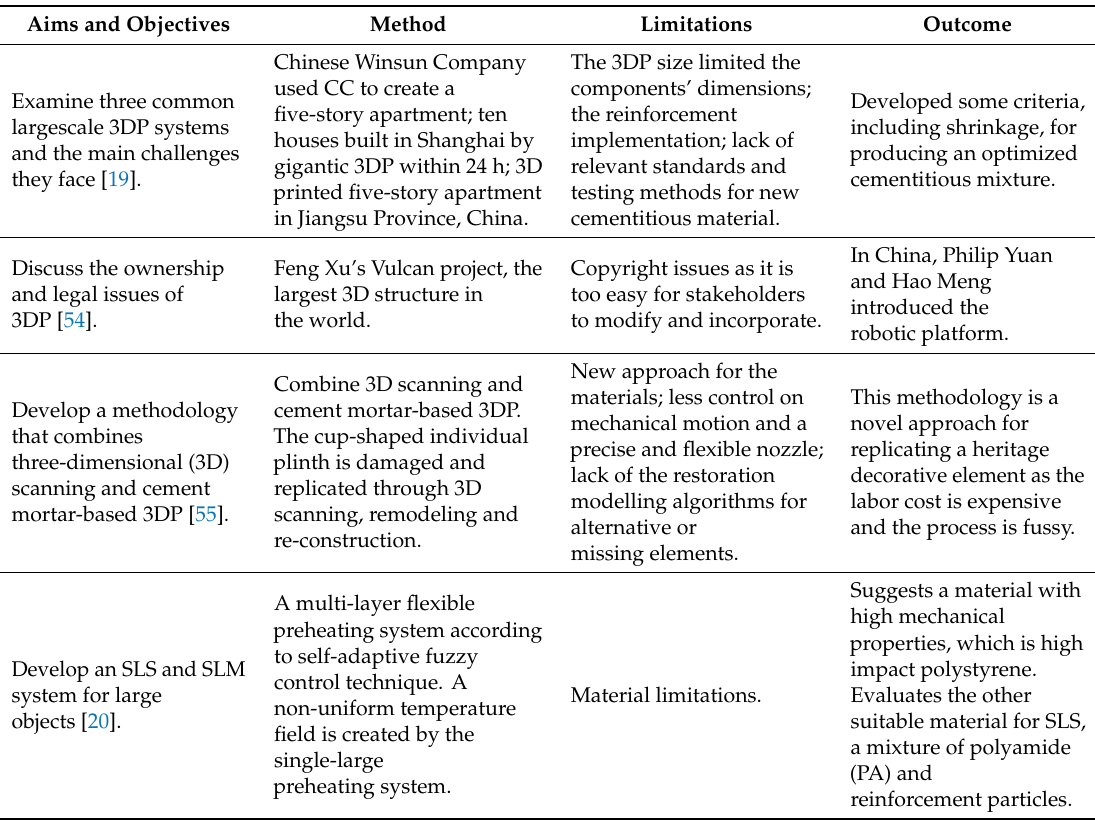
methods, including selected cases in